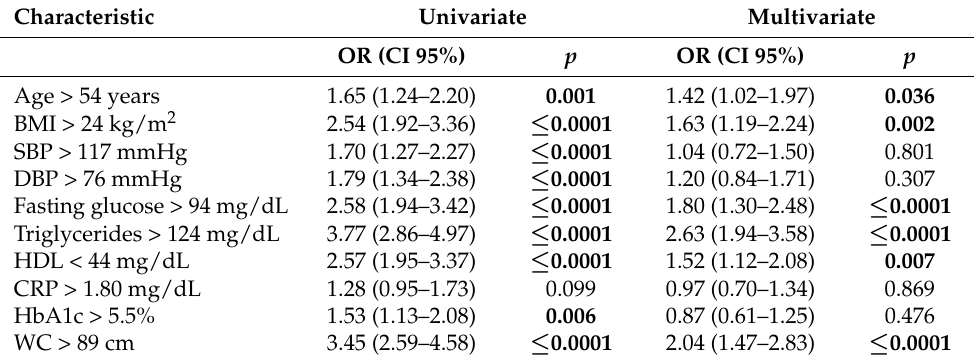
Table 4. Univariate and multivariate analysis for steatosis in patients with BMI < 25 kg/m 2